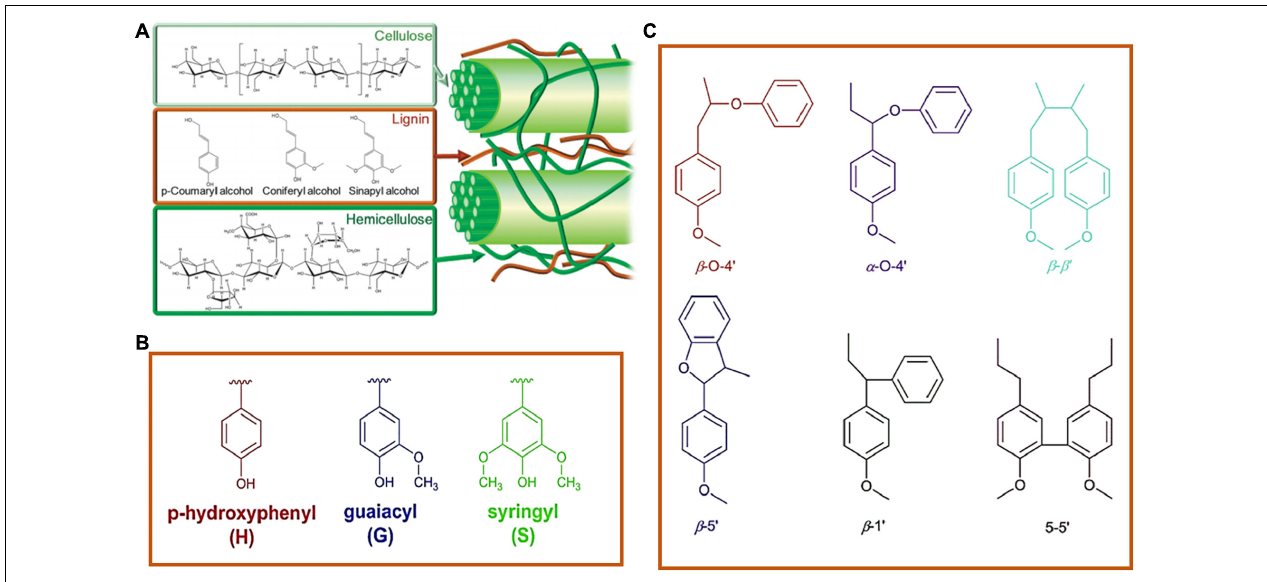
FIGURE 1 | (A) Typical structure of lignocellulose (Zhu et al., 2020). (B) Precursors and (C) common interunit linkages (Luis Espinoza-Acosta et al., 2018).